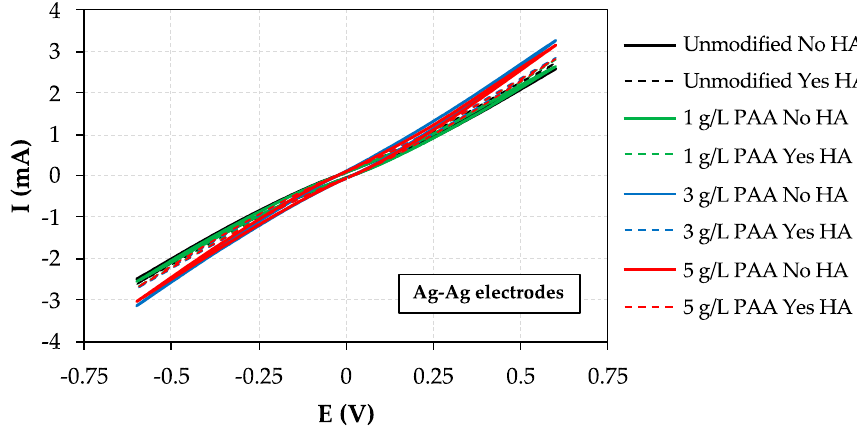
Figure 5. Cyclic voltammetry analyses: e ff ect of PAA concentration in AEM modification at Ag electrodes.